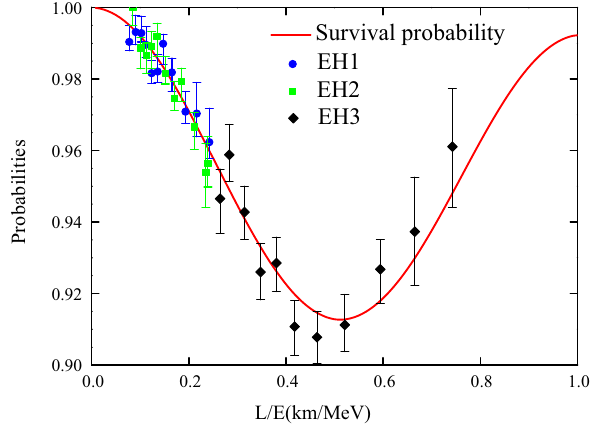
Fig. 1 The survival probability ν e → ν e as a function of the distance traveled per energy L / E with initial electron flavor state. The theoret- ical predictions (red line) and the experimental data from Daya Bay collaboration [3] in three underground experimental halls (EH1: blue, circle; EH2: green, square; EH3: black, rhombus) have been